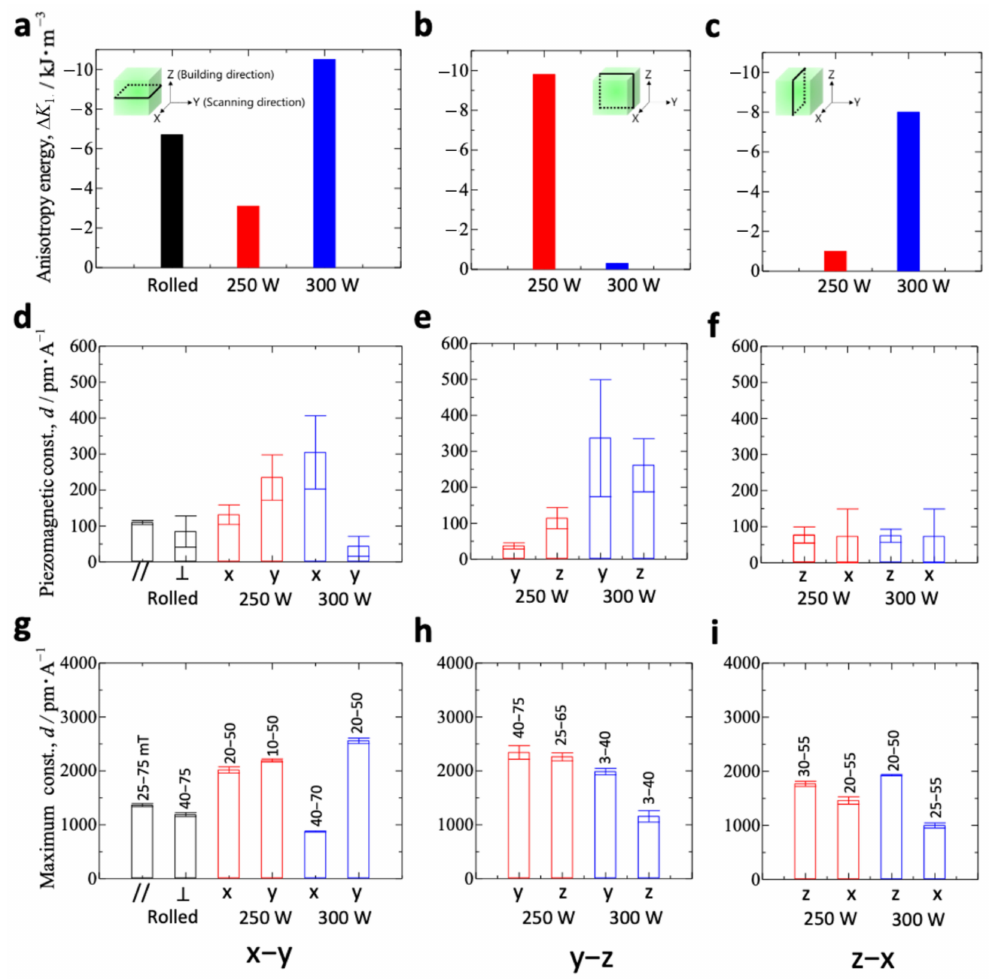
Figure 4. The anisotropy energy ∆ K 1 for additive-manufactured Fe–Co bulk alloy samples on the ( a ) x – y plane, ( b ) y – z plane, and ( c ) z – x plane. The results of the piezomagnetic constant d for the ( d ) x – y plane, ( e ) y – z plane, and ( f ) z – x plane. The maximum piezomagnetic constant d for ( g ) the x – y plane, ( h ) y – z plane, and ( i ) z – x plane. The same sample was measured three times and the mean plotted. Error bars indicate standard